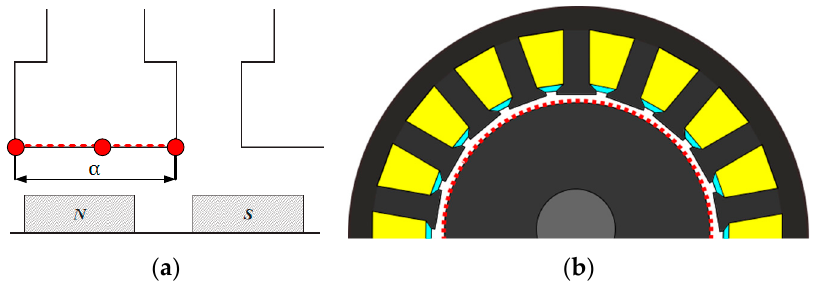
Figure 6. Surfaces on which magnetic pressures were analyzed: ( a ) base of a stator tooth; ( b ) outer surface of the rotor.